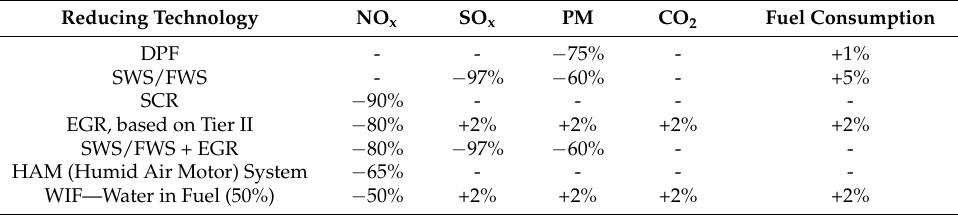
Table 2. Emission and fuel consumption changing factors of abatement technologies [29,30].